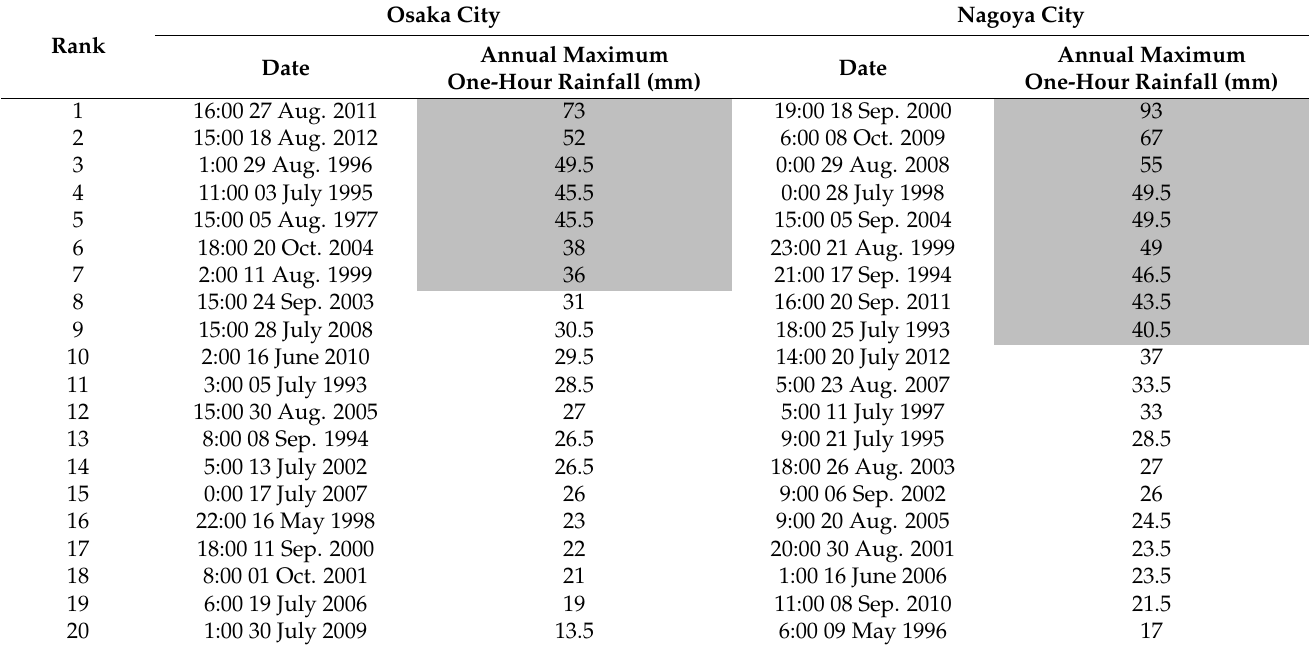
Table 2. Annual maximum one-hour rainfall during 1993–2012 in Osaka and Nagoya Cities. The shaded values are greater than the average for each